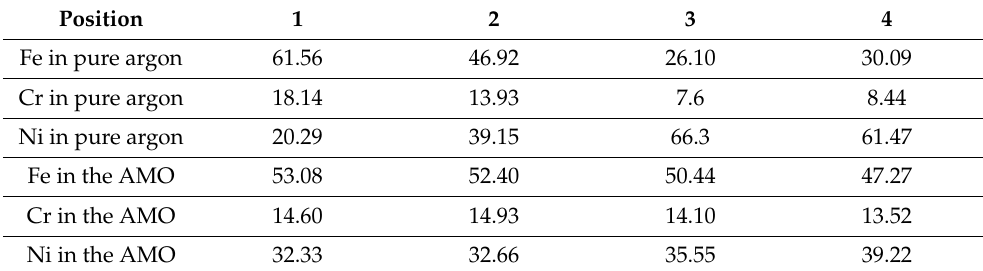
Table 5. Chemical compositions of four positions by EDS point scanning (atomic fraction